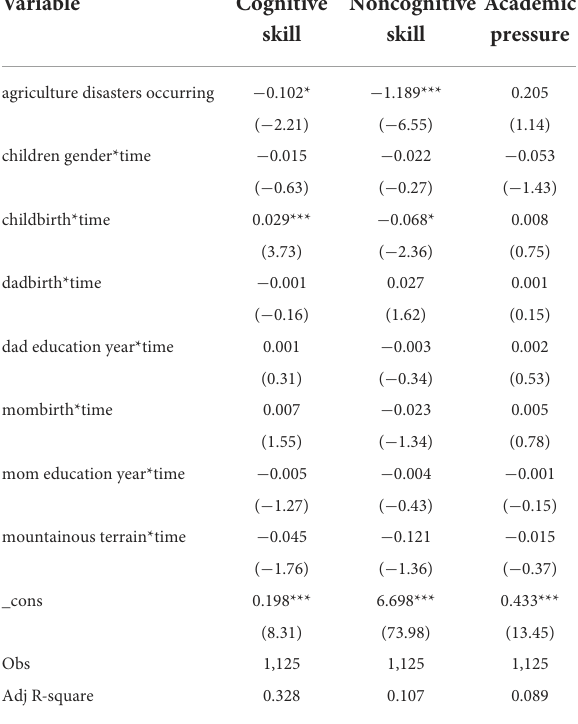
TABLE 2 DID regression result of subsample regression of appearances 3 times.